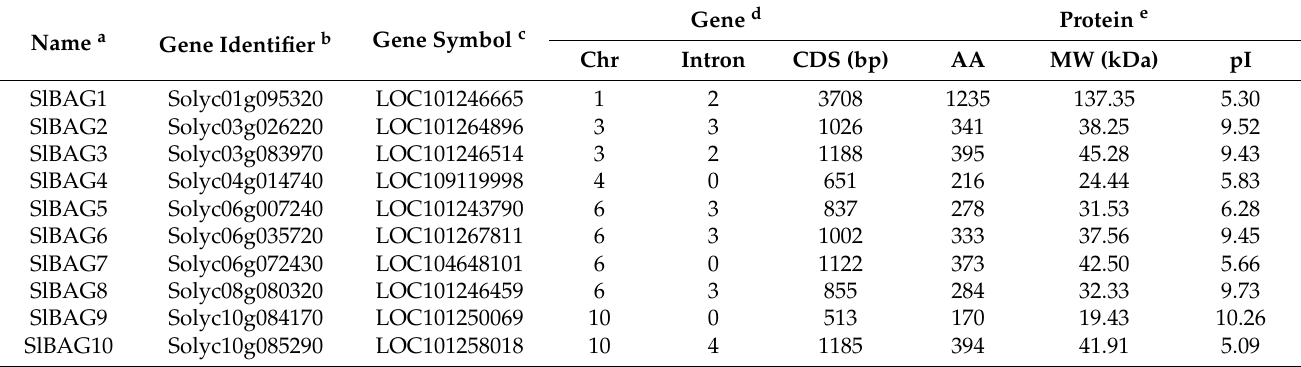
Table 1. The sequence characteristics of SlBAG family members in